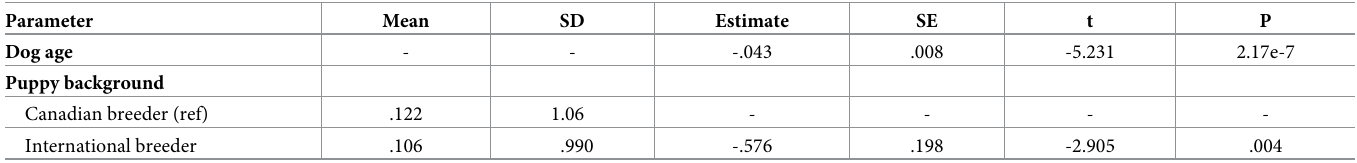
Table 5. Statistically significant interactions of owner and dog parameters on CBARQ Factor 2 “Excitability”.